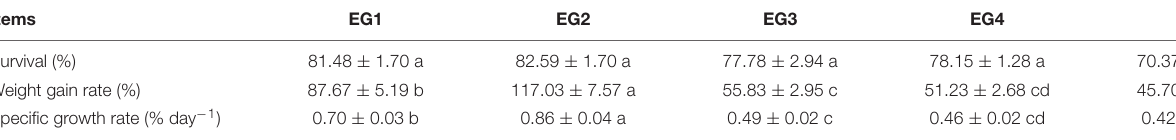
TABLE 1 | Survival rate and growth performance of juvenile peanut worm S. nudus .